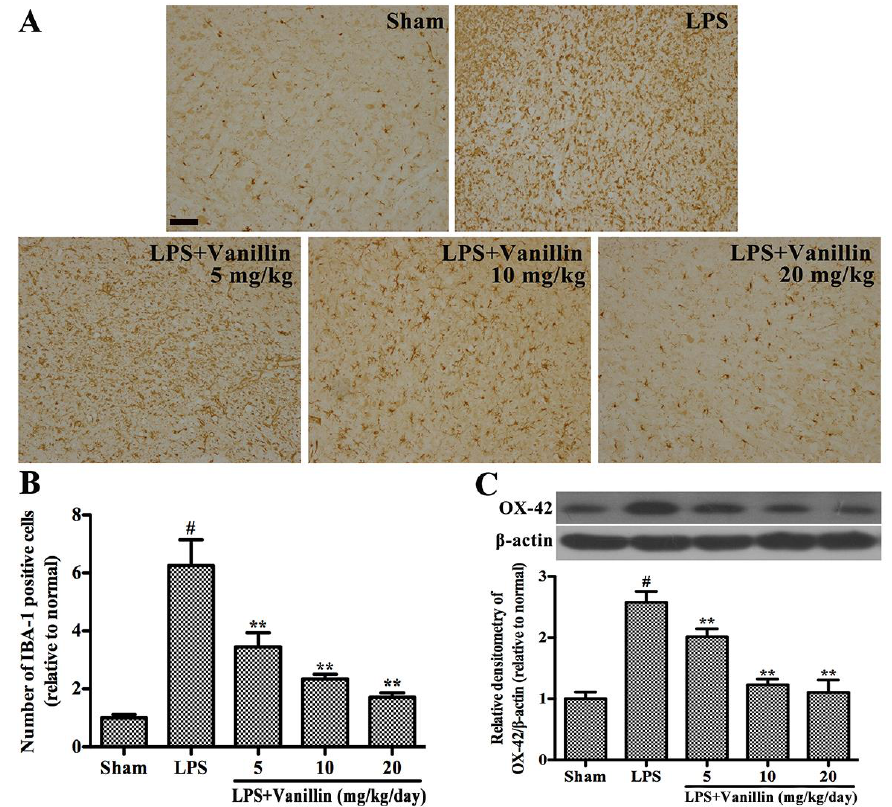
Figure 3. Vanillin inhibits LPS-induced activation of microglia in the SN. The PD model rats were anaesthetized and decapitated to obtain the SN after 24 days of vanillin administration. ( A ) immunohistochemical results of ionized calcium-binding adaptor molecule-1 (IBA-1)-positive cells, scale bar represents 100 μm; ( B ) the number of IBA-1-positive cells; ( C ) O-X42 expression. # p < 0.01 vs. the sham-operated control rats; and. ** p < 0.01 vs. the vehicle treated LPS-injected rats.